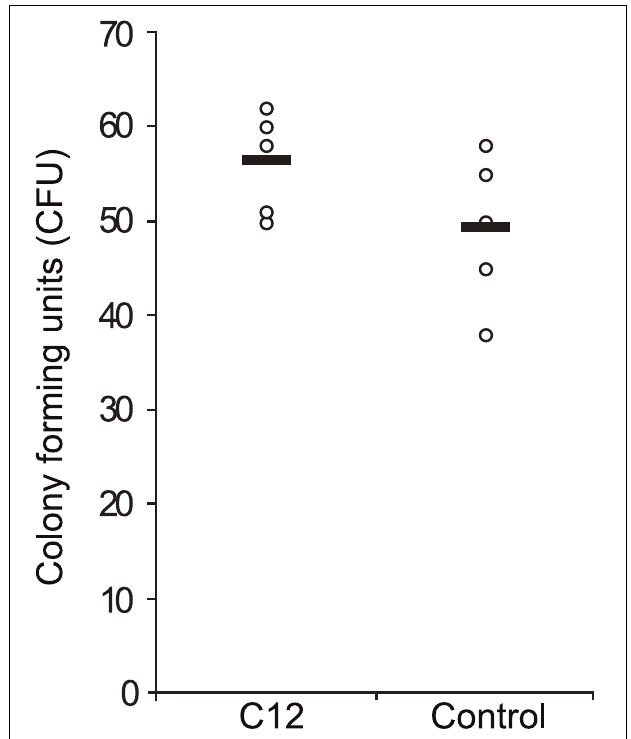
FIGURE 4 | Effect of C12 on yeast response to oxidative stress. A single colony of S. cerevisiae strain BY4741 was inoculated in liquid YPD medium and grown with agitation for 4 h at 30 ◦ C. Then, aliquots of this dilution were pre-incubated with 50 µ M C12 for 30 min and thereafter exposed to 0.1% H 2 O 2 for 10 min. After exposure to oxidative stress the cells were diluted 1:100 in YPD medium and plated on YPD agar. After 96 h, the number of colony forming units (CFU) was counted as a measure of viable cells and compared between treatments. CFU counts for replicate samples are represented by circles ( n = 5), and black bars indicate the mean of each group.